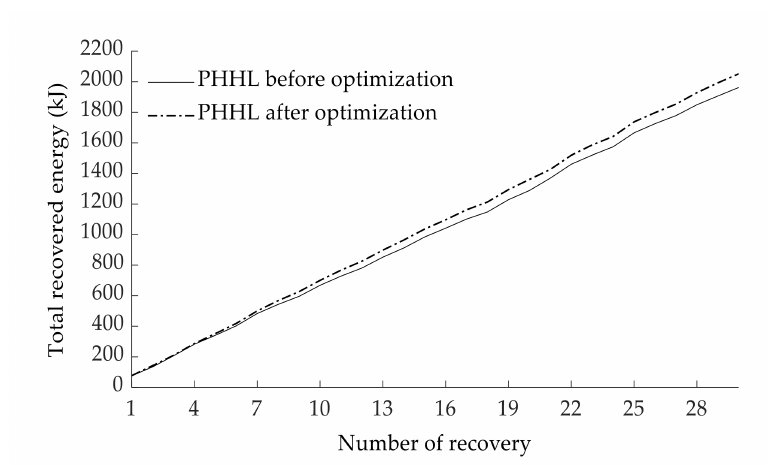
Figure 19. Total recovered